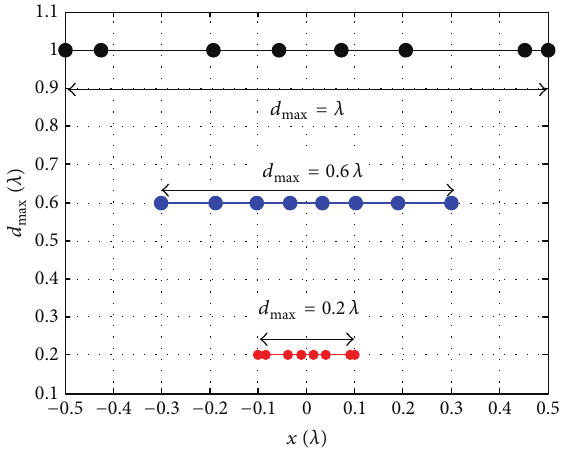
Figure 11: Optimal layout for Scenario V with various 𝑑 max .